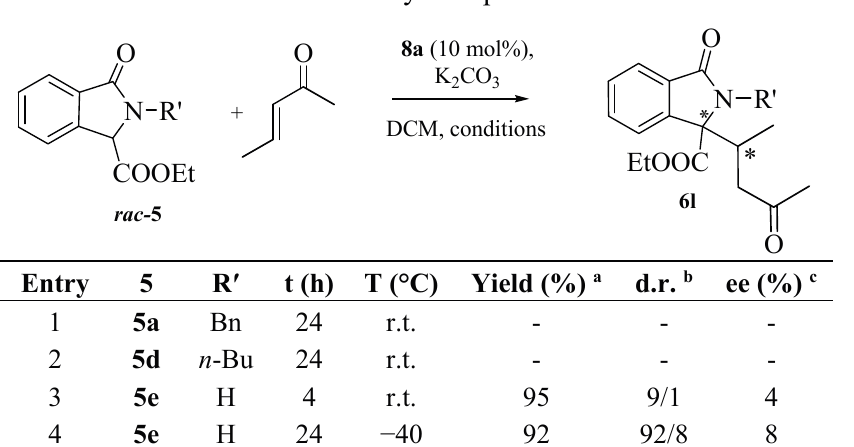
Table 4. Reactivity of